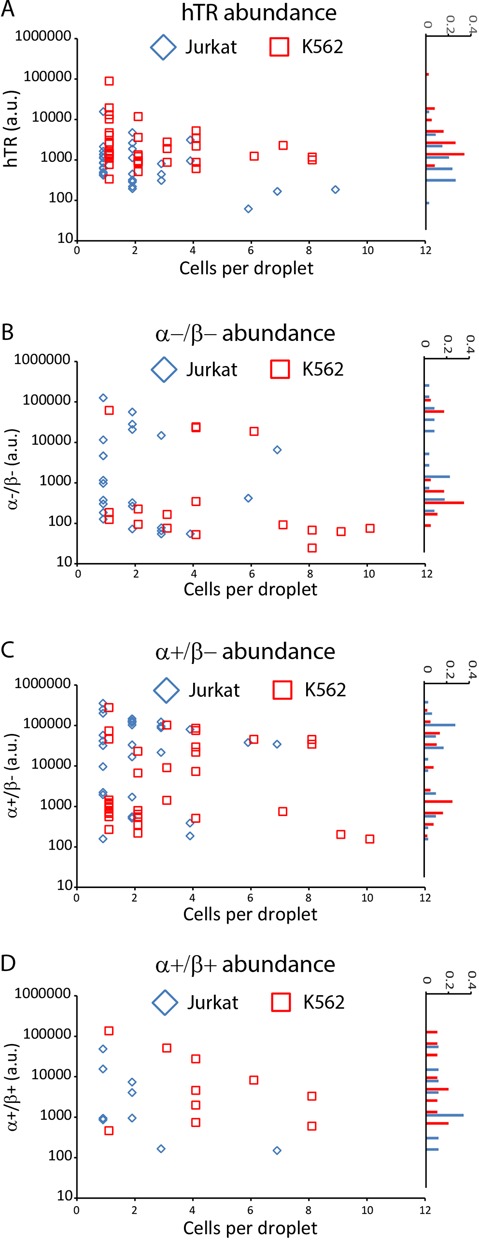
(A–D) Scatter plot of cell number per droplet versus transcript abundance for hTR and 3 hTERT variants (left graph in each panel) with corresponding histograms of transcript abundance frequencies (right graph in each panel) for Jurkat (blue diamonds) and K562 (red squares) cell lines. The α−/β+ variant was not expressed in a significant number of colonies and was omitted. The α−/β− and α+/β− splice variant abundances approach bimodal patterns in both cell types, though only the α+/β− splice variant in K562 cells is statistically significant (dip = 0.0823, P = 0.0424). The transcript abundances of hTR and the α+/β+ variant are not bimodal.